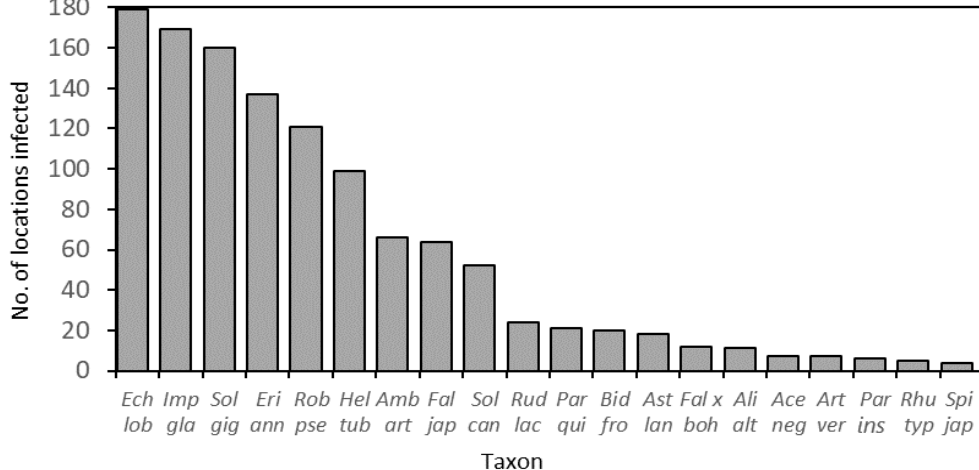
Figure 2. The number of reaches of the riparian zone in which individual IAS were recorded.